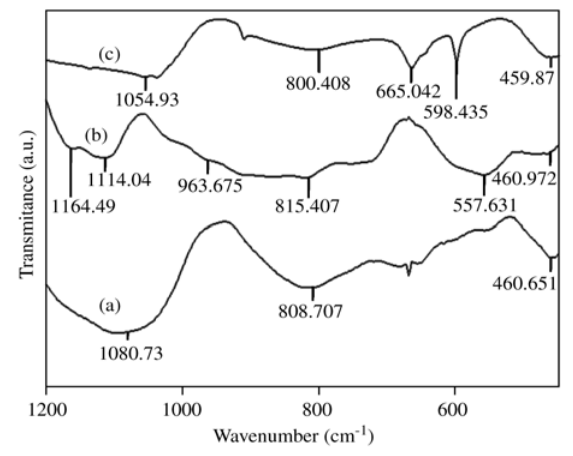
Figure 1. FTIR spectra of FM ® fibers: a) before any chemical treat- ment, b) after TEOS treatment, c) FM after TEOS treatment and immersed for 10 days in SBF